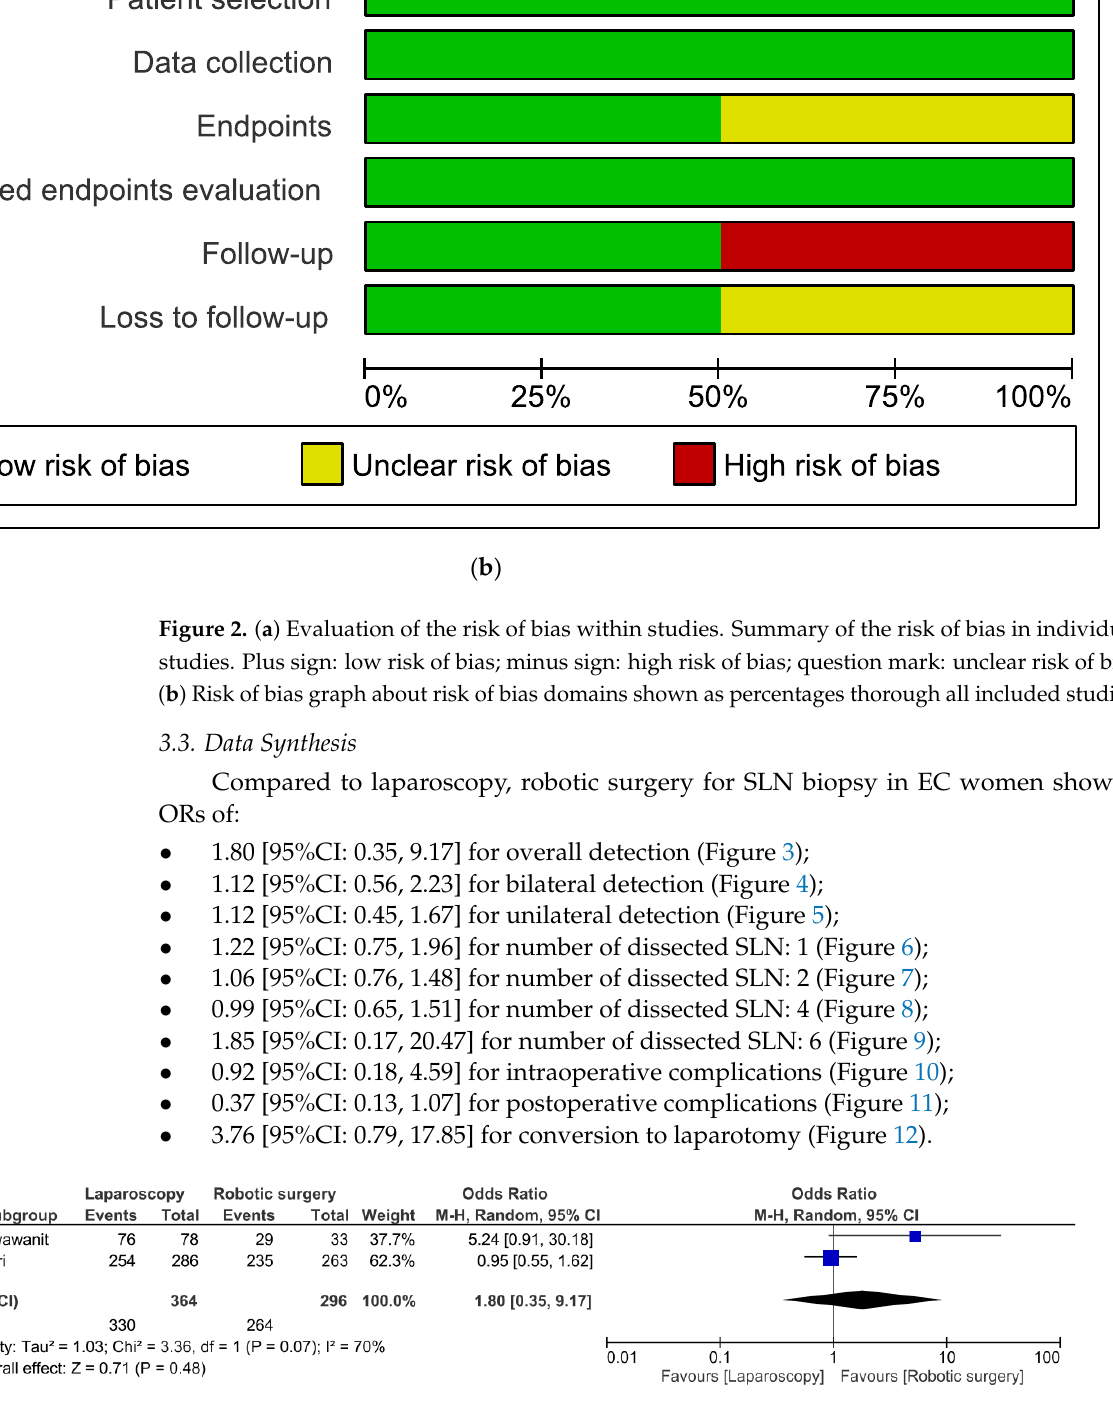
Figure 4. Forest plot of individual and pooled odds ratios, with 95% confidence interval (CI), for bilateral detection, comparing laparoscopy and robotic surgery for SLN biopsy in EC women.